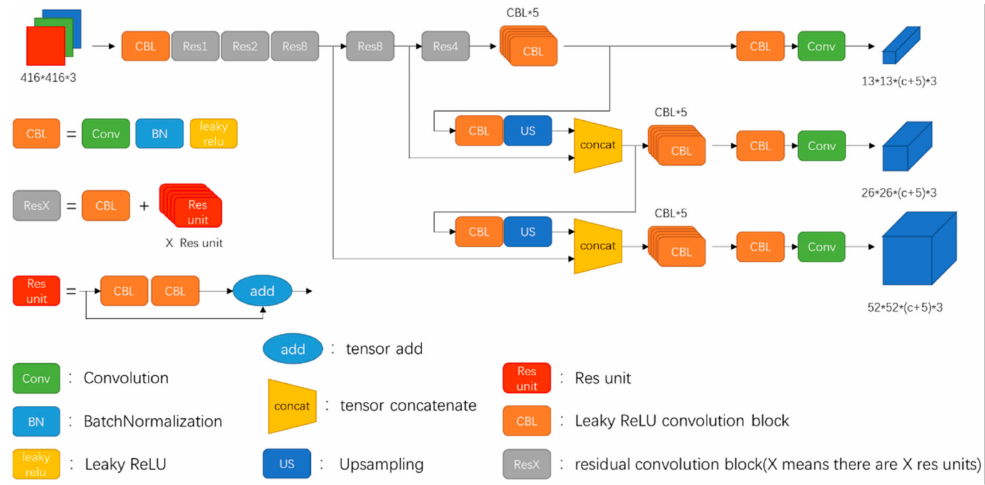
Figure 1. Framework of